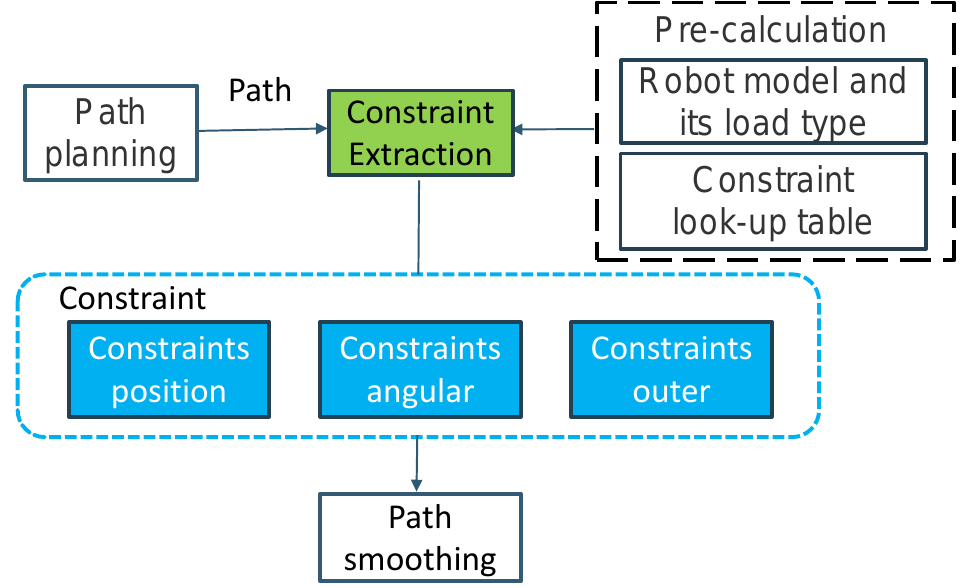
Figure 5. Block diagram of the safety envelope constraint extraction system: After the path-planning module had searched for a collision-free path, it extracted the safety envelope constraint of the path, and the extracted envelope was used as a constraint item for path smoothing. The offline pre-calculation module included the calculation of the robot safety envelope set and the generation of the lookup